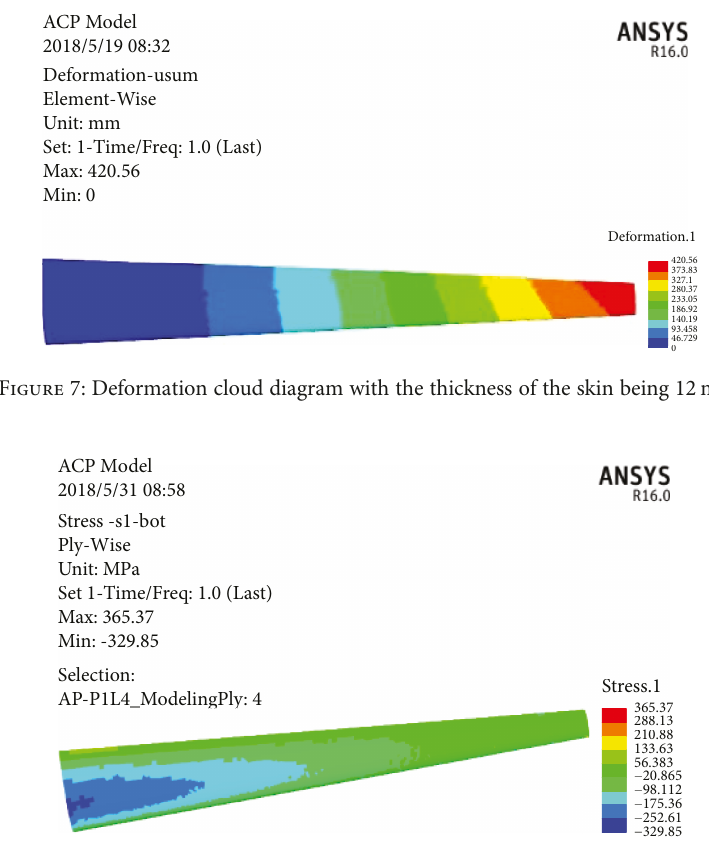
Figure 8: Stress cloud diagram of the upper wing with the thickness of the skin being 12 mm.